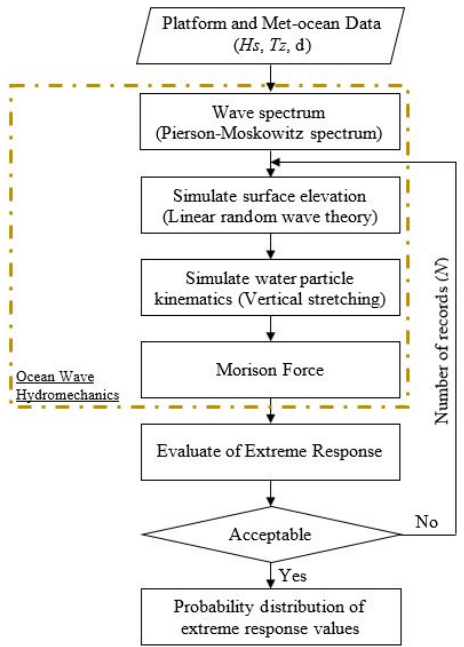
Figure 2. Procedure of the evaluation of extreme structural responses using the MCTS procedure.